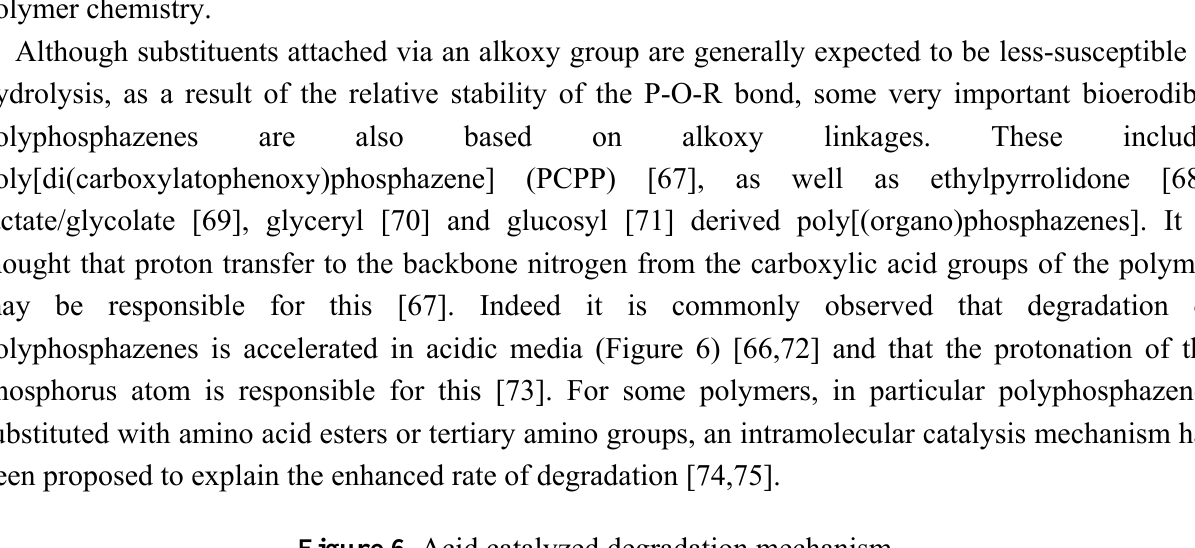
Figure 6. Acid catalyzed degradation mechanism.